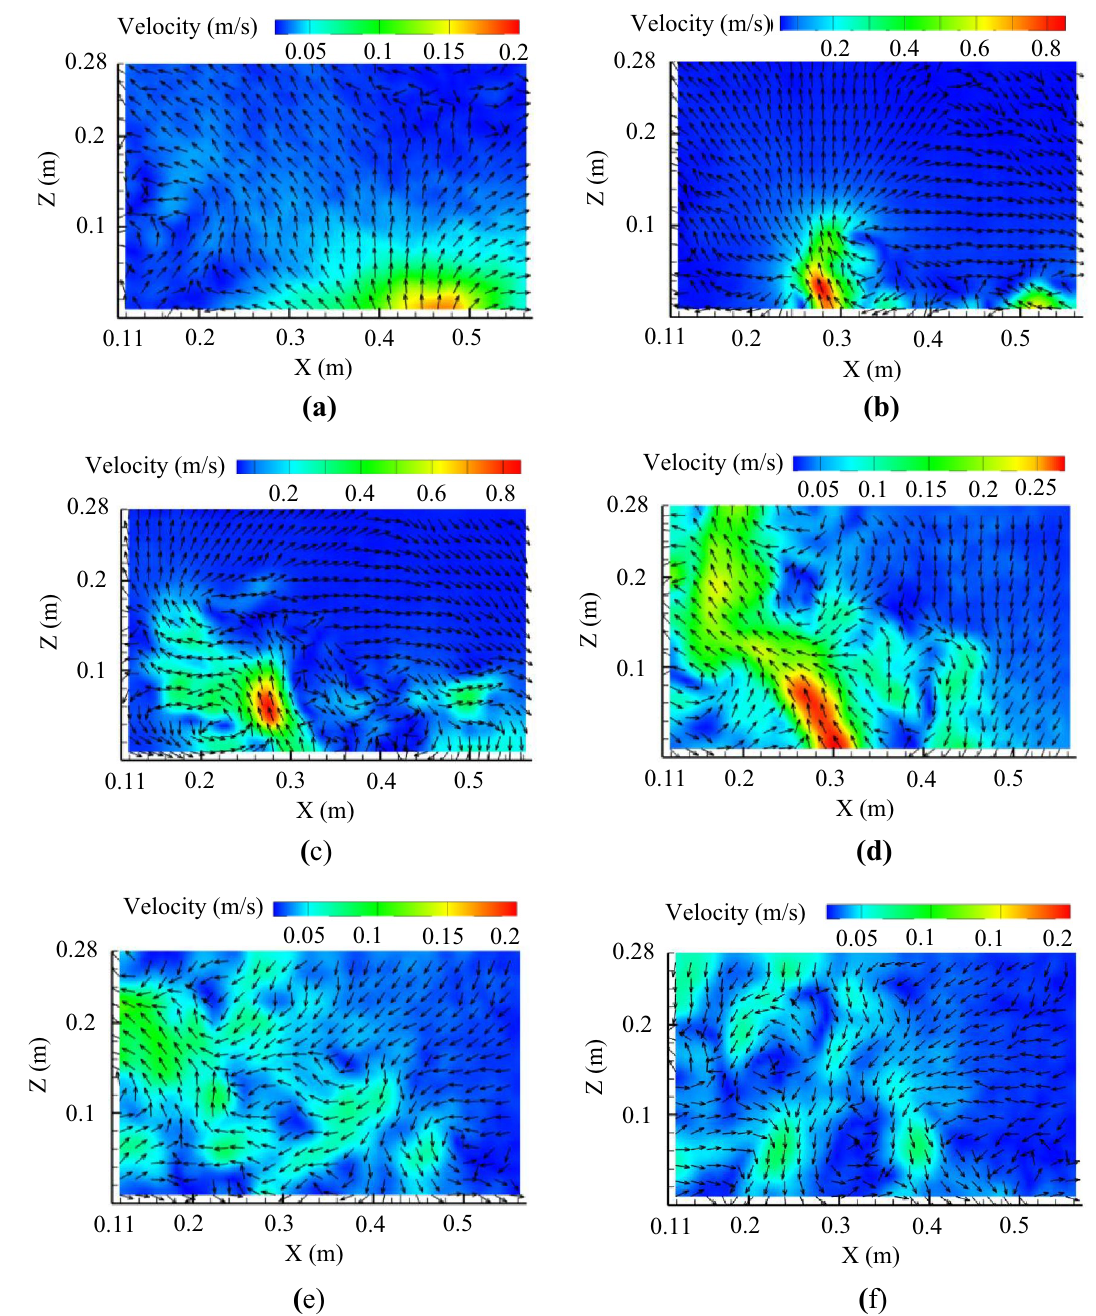
Figure 3. Measured transient air velocity distributions in the region of interest (ROI) after flushing toilet by PIV: ( a ) at t = 0.2 s, ( b ) at t = 0.5 s, ( c ) at t = 1.0 s, ( d ) at t = 2.0, ( e ) at t = 3.0 s, ( f ) at t = 4.0